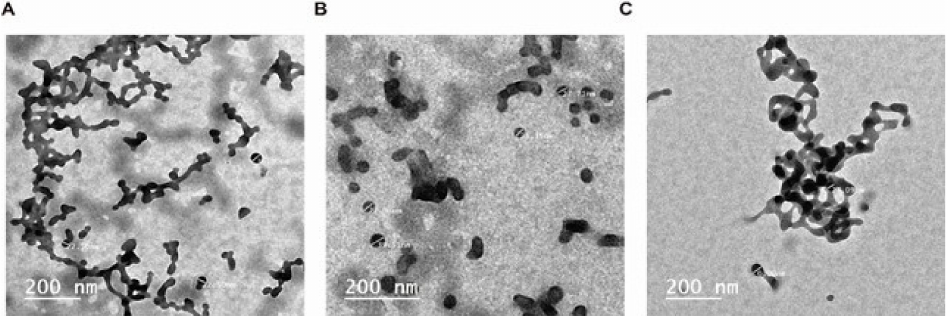
Figure 1. Transmission electron microscope TEM micrographs of unloaded control (left panel A ), CUR-loaded PEG-NPs (right panel B and C